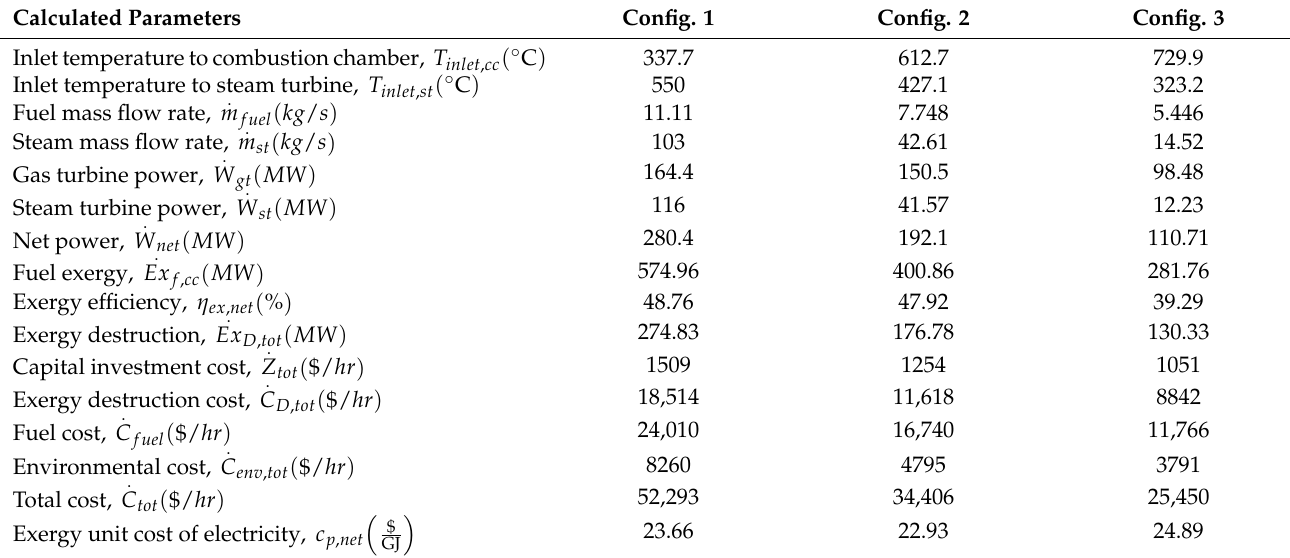
Table 8. Output values for different configurations of the present